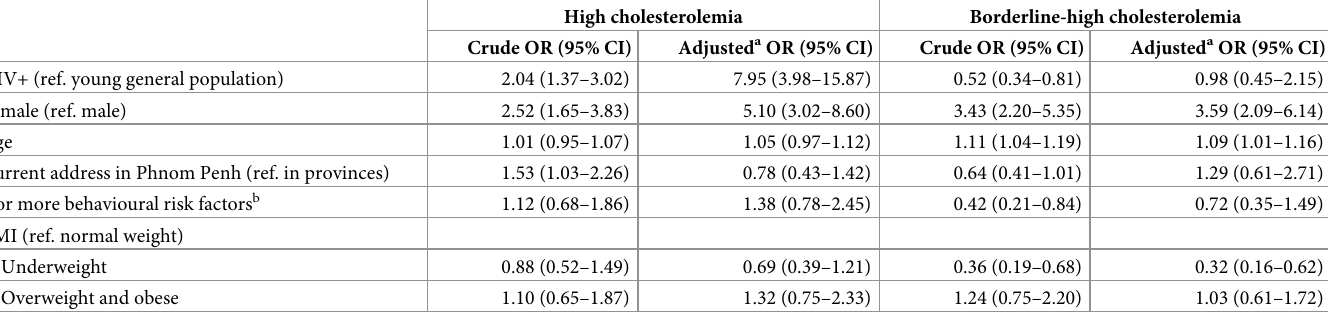
Table 4. Association between high and borderline-high cholesterolemia and HIV, STEPS, Cambodia, 2016 and